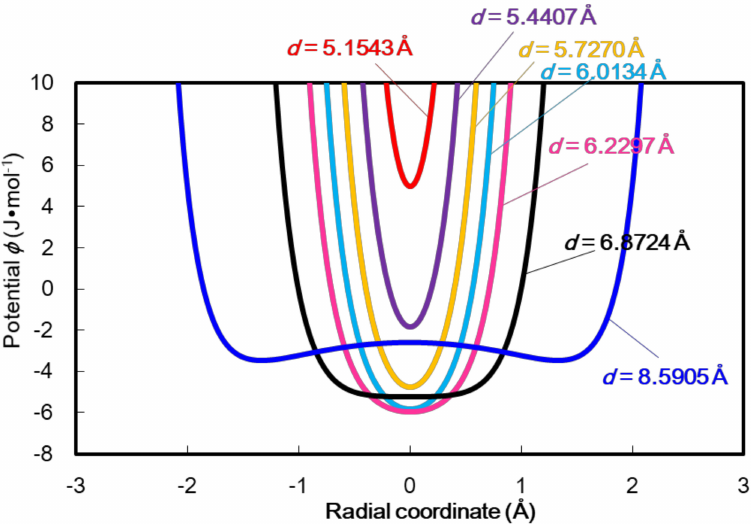
Figure 3. Hydrogen potential distribution inside cylindrical silica pores with different pore